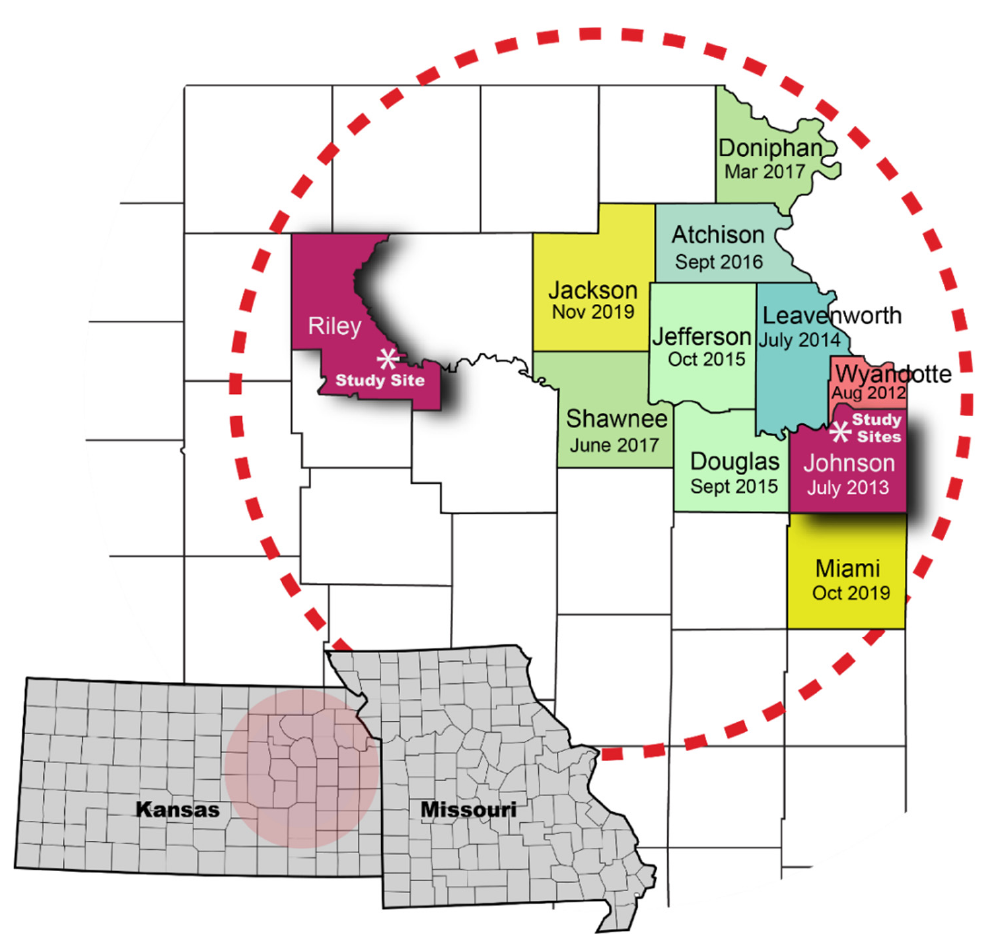
Figure 2. Map shows counties in Kansas with dates of confirmed EAB infestation. Study areas are in Johnson and Riley counties (both shown in purple). Riley County had no confirmed infestation at the time of this research.